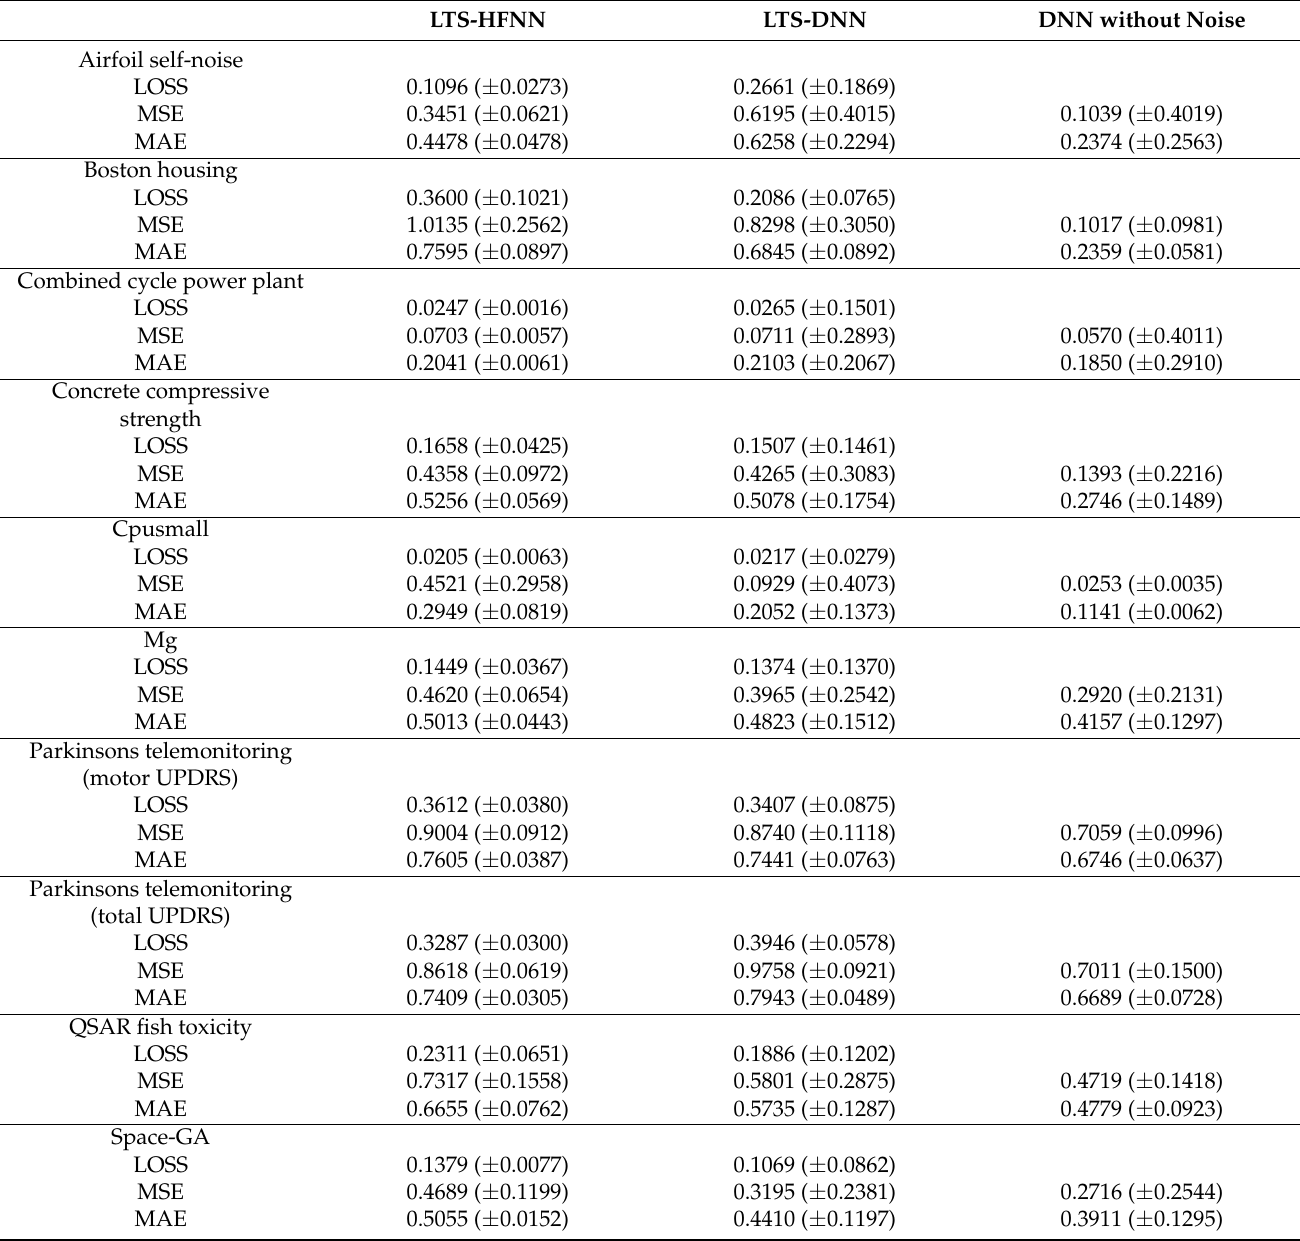
Table 4. Simulation results in Example